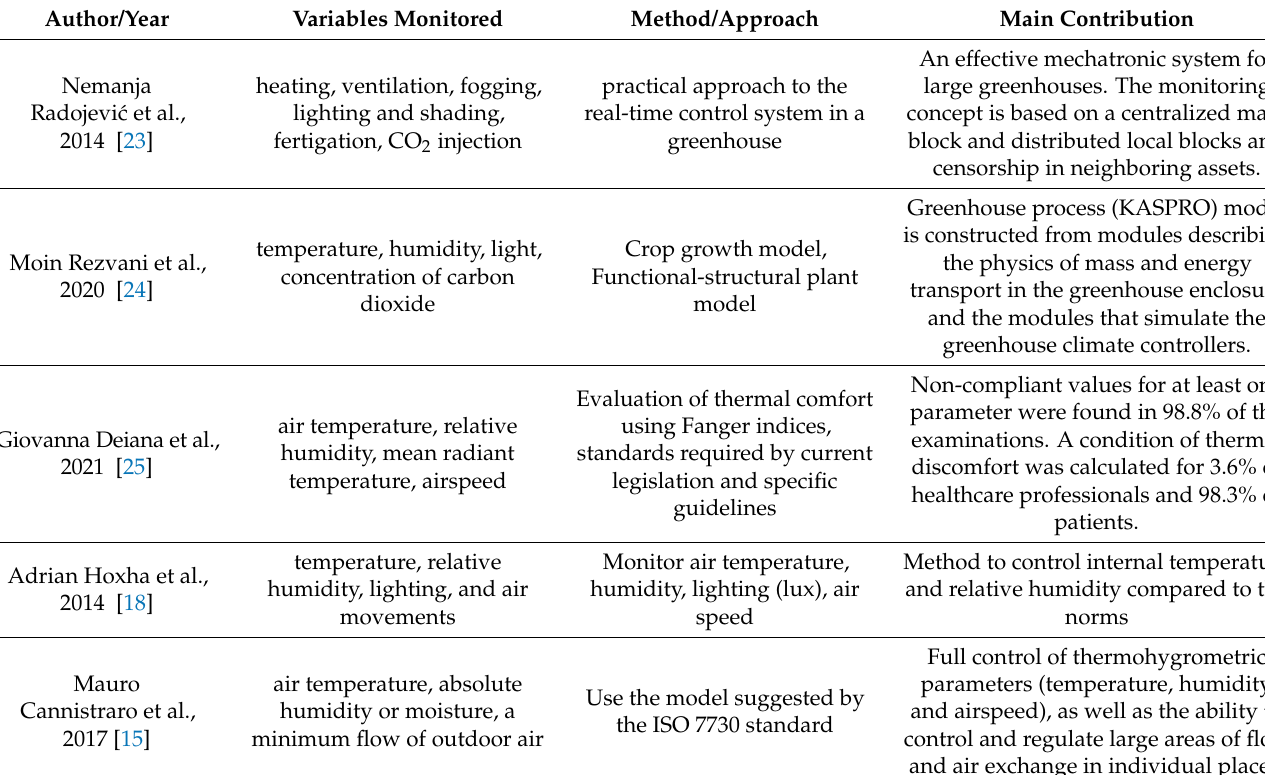
Table 1. Comparison of methods/approaches in microclimate control